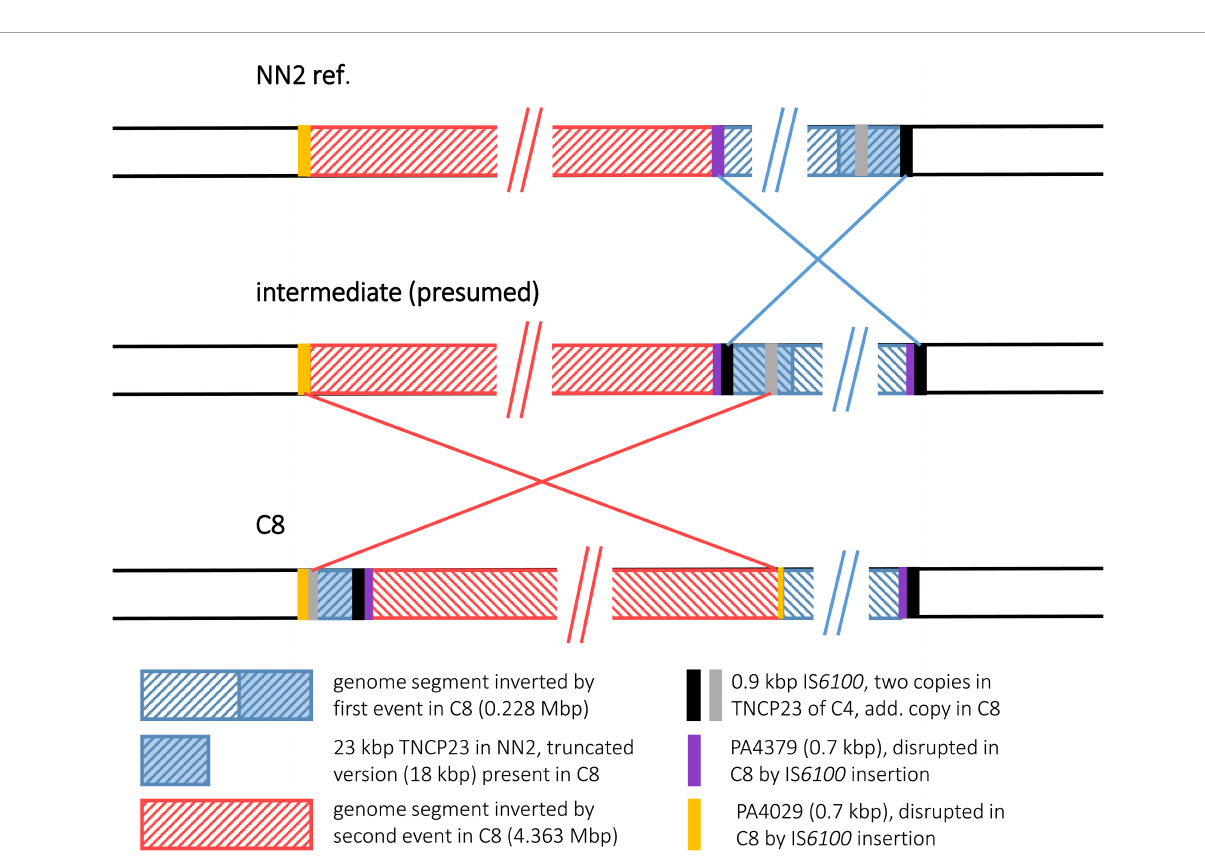
FIGURE3 Genomic inversion in strain C4.